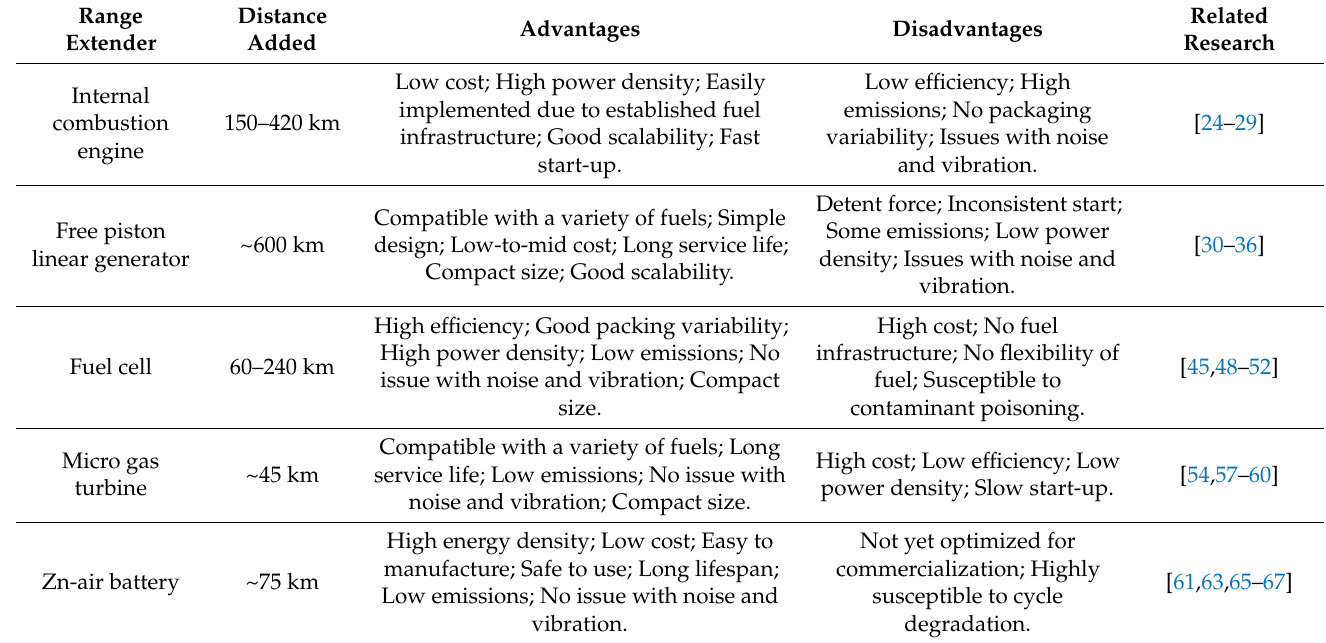
Table 1. Comparison of different range extending technologies in electric